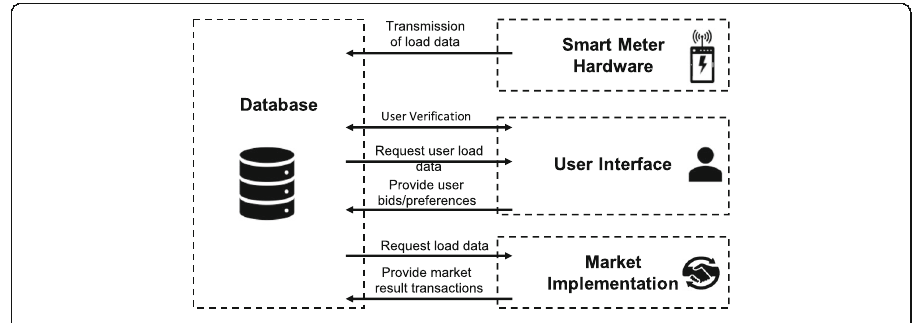
Fig. 1 Fundermental LEM